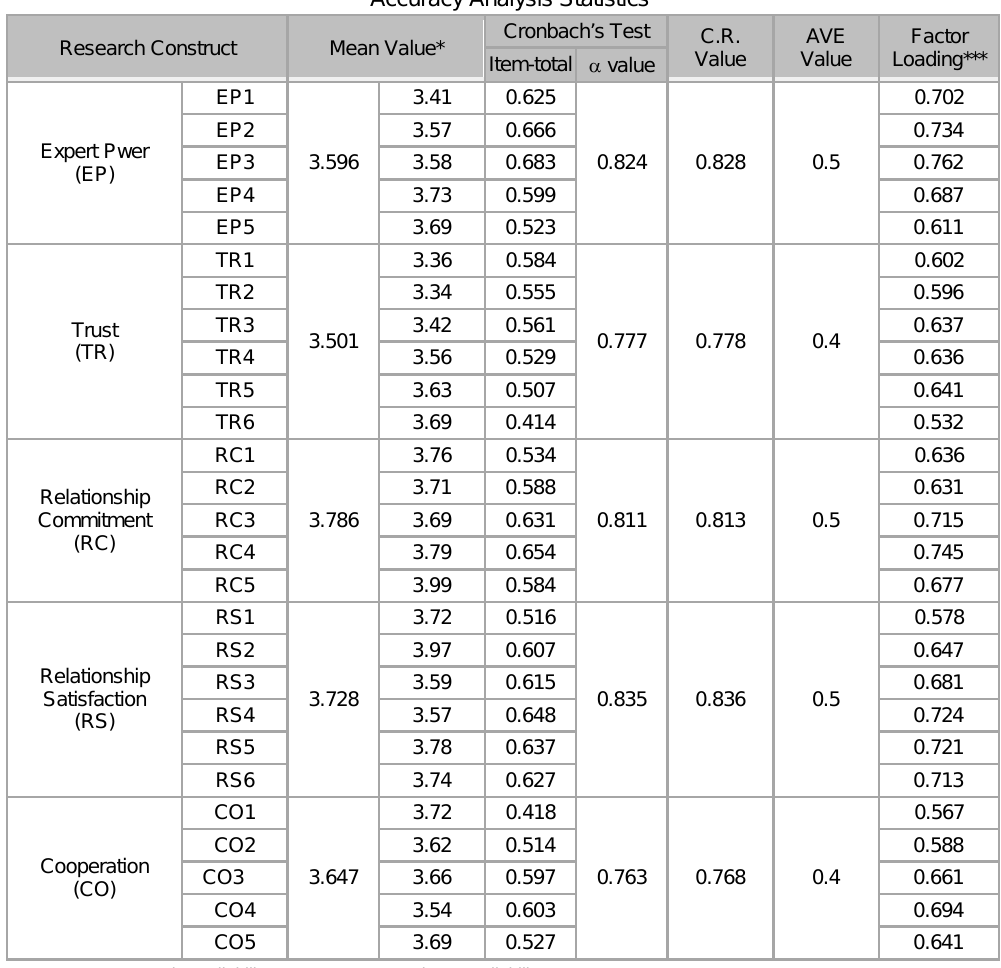
Accuracy Analysis